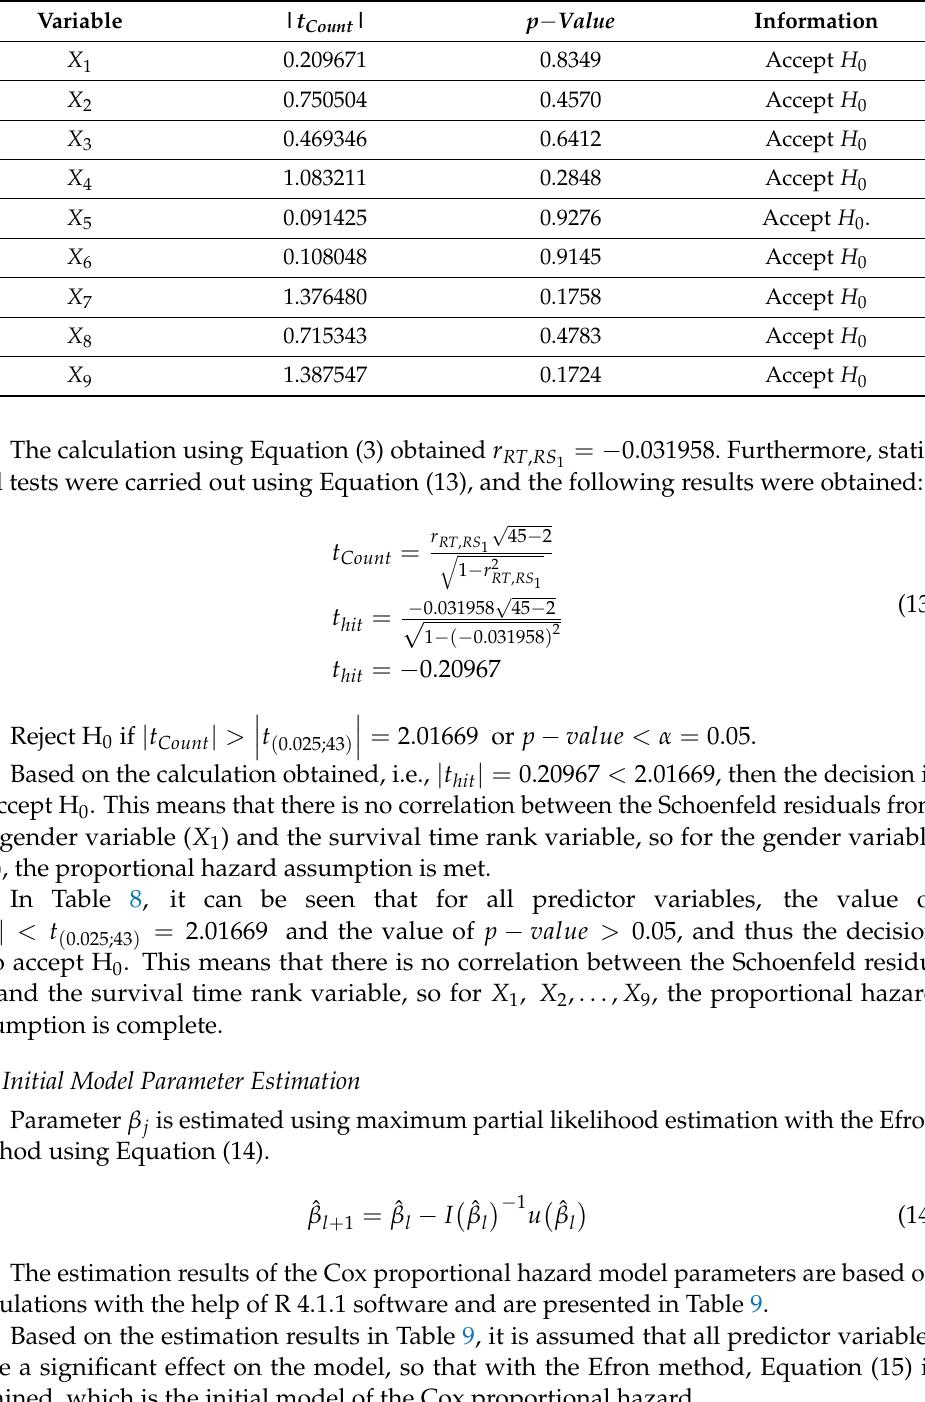
Table 8. Cox proportional hazard assumption test